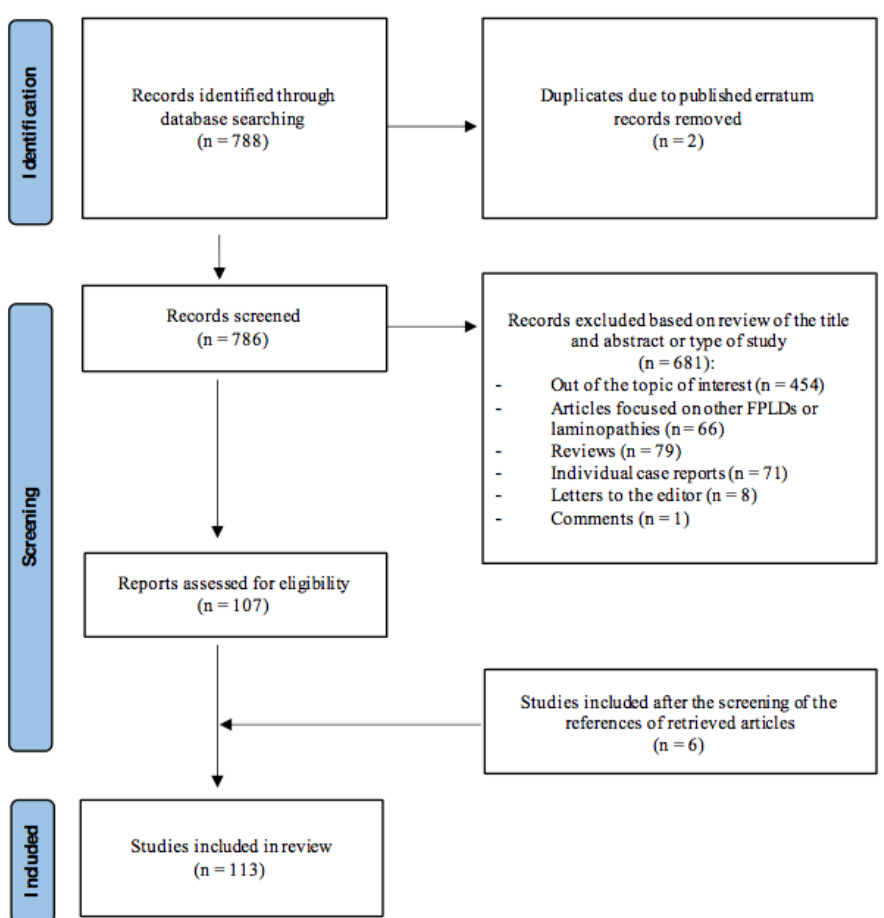
Figure 2. Search strategy and flow diagram of articles.